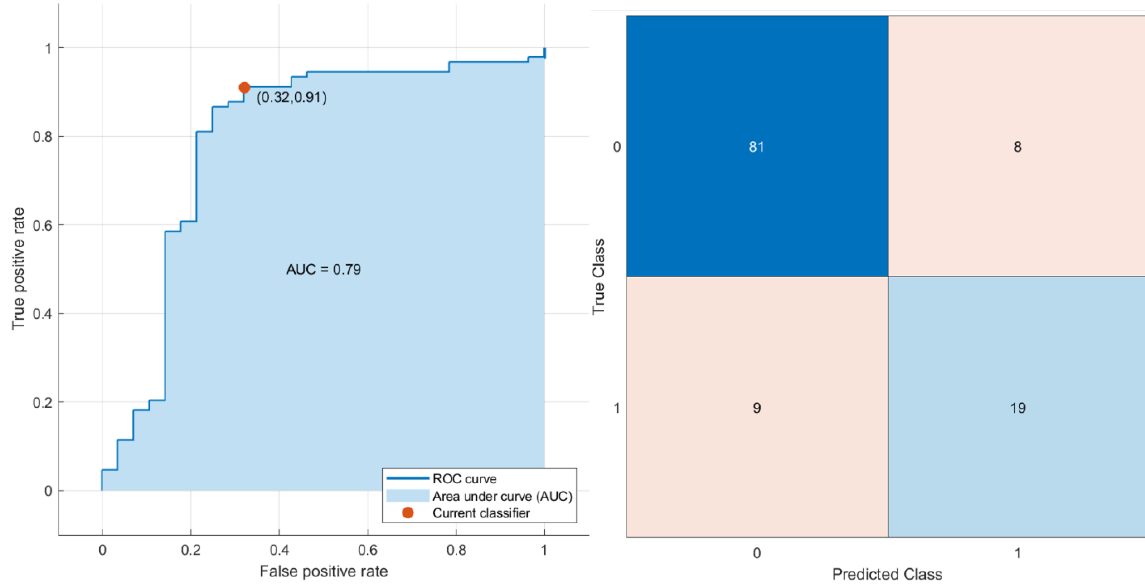
Figure 4. ROC curve and confusion matrix of the SVM model.